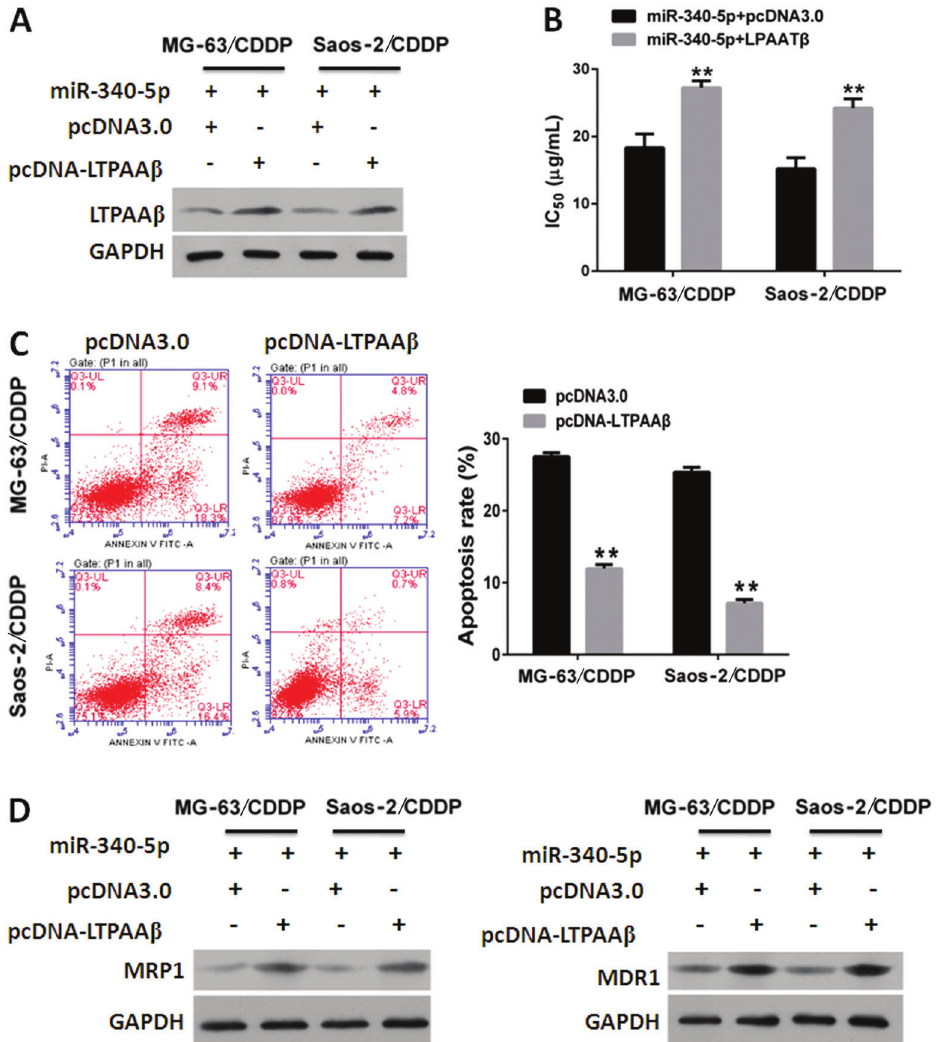
compromised inhibitory effects of miR-340-5p on IC50 of CDDP in MG-63/CDDP and Saos-2/CDDP cells. C , Expression of LPAAT b attenuated promoting effects of miR-340-5p on CDDP-induced apoptosis in MG-63/CDDP and Saos-2/CDDP cells. Data are reported as means ± SD. **P o 0.01 (Student ’ s t -test). D , Expression of LPAAT b compromised inhibitory effects of miR-340-5p on expression of MRP1 and MDR1 in MG-63/CDDP and Saos-2/CDDP cells exposed to